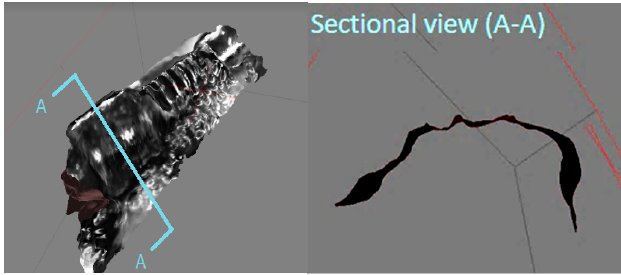
Figure 8. Object reconstructed by absolute light.